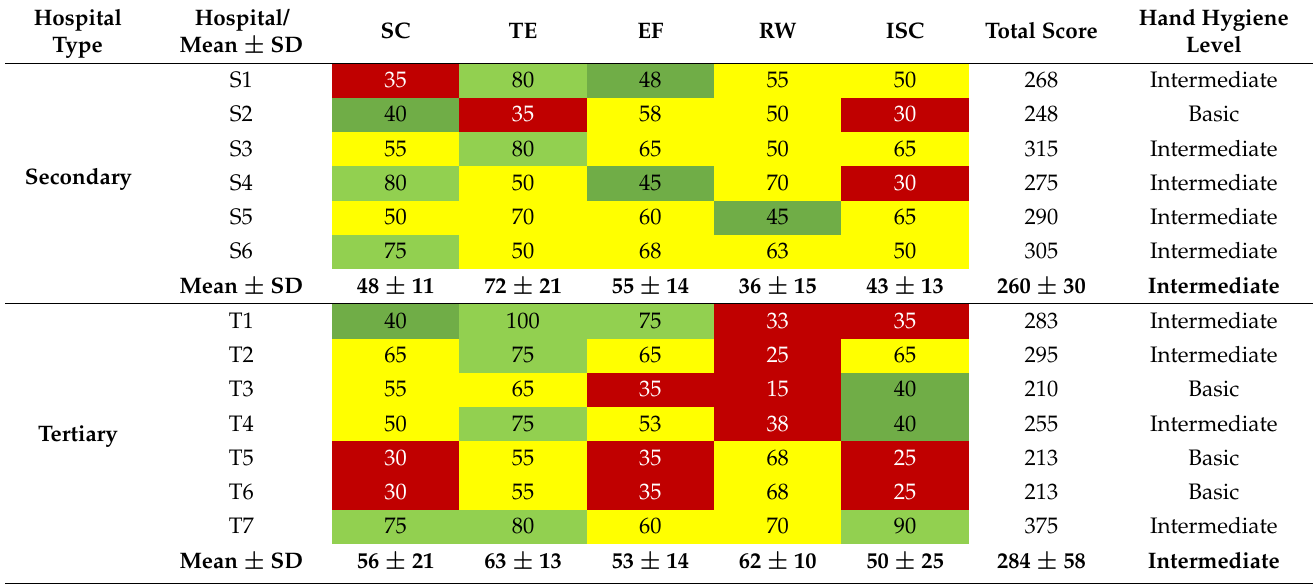
Table 4. The 2021 HHSAF assessment scores of 13 public hospitals in the Western Area of Sierra